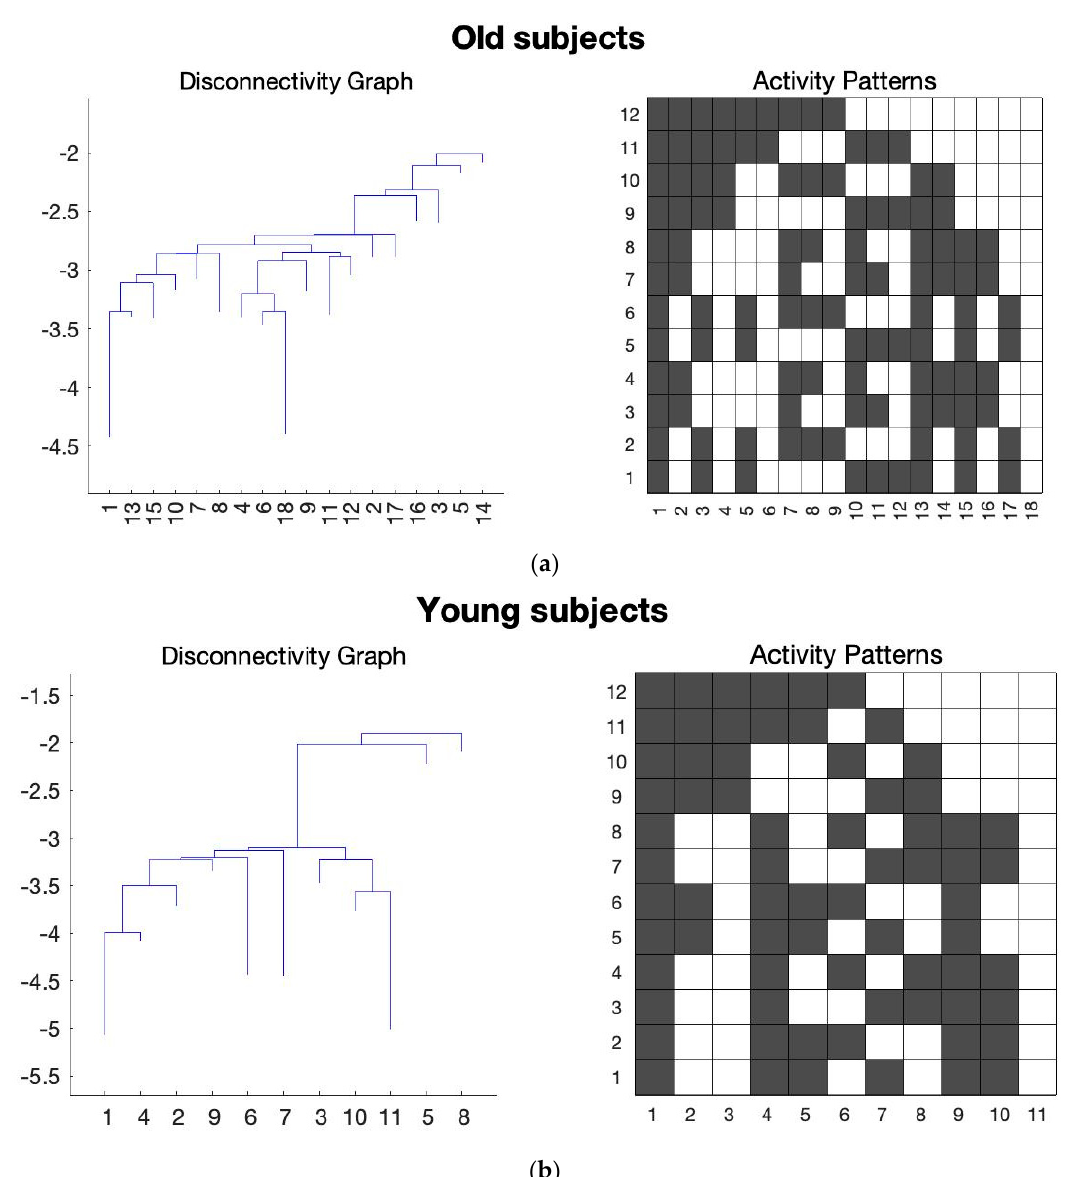
Figure 1. The average of all the subjects for the FPN was taken and the energy landscape analysis was conducted to generate the disconnectivity graph and activity pattern. Here, the x -axis of the disconnectivity graph represents the local minima number and y -axis shows its corresponding energy value. For the activity patterns, x -axis is the local minima number and y -axis shows the ROIs for FPN. ( a ) Energy landscape analysis conducted on the average of the old subjects for FPN. ( b ) Energy landscape analysis conducted on the average of the young subjects for FPN.